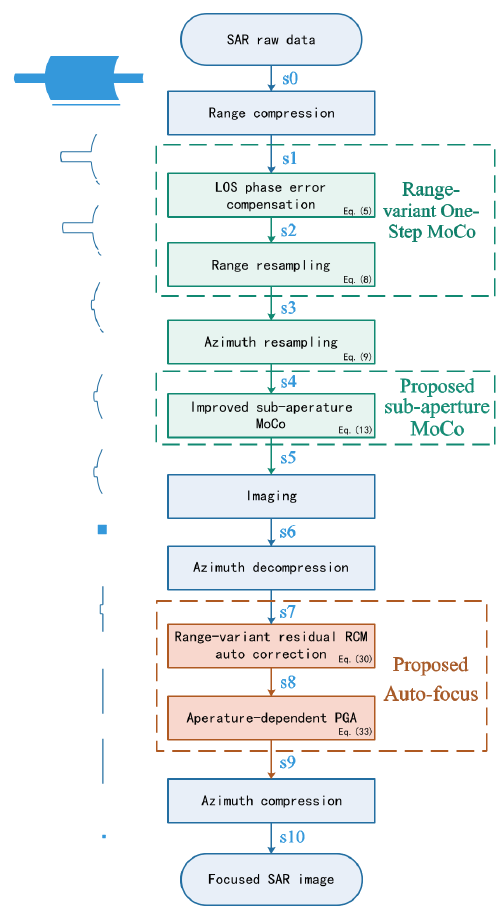
Figure 7. Flowchart of proposed MoCo scheme.